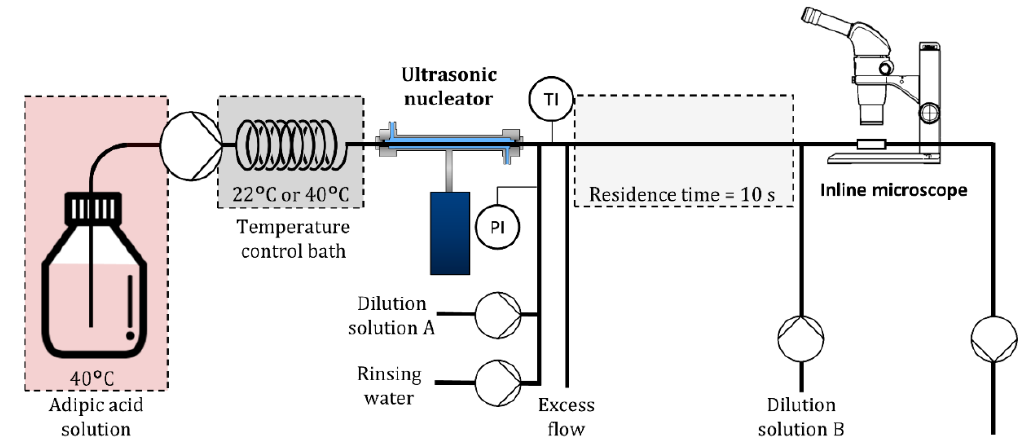
Figure 1. Experimental setup for the evaluation of the nucleation rate in an ultrasonic nucleator.